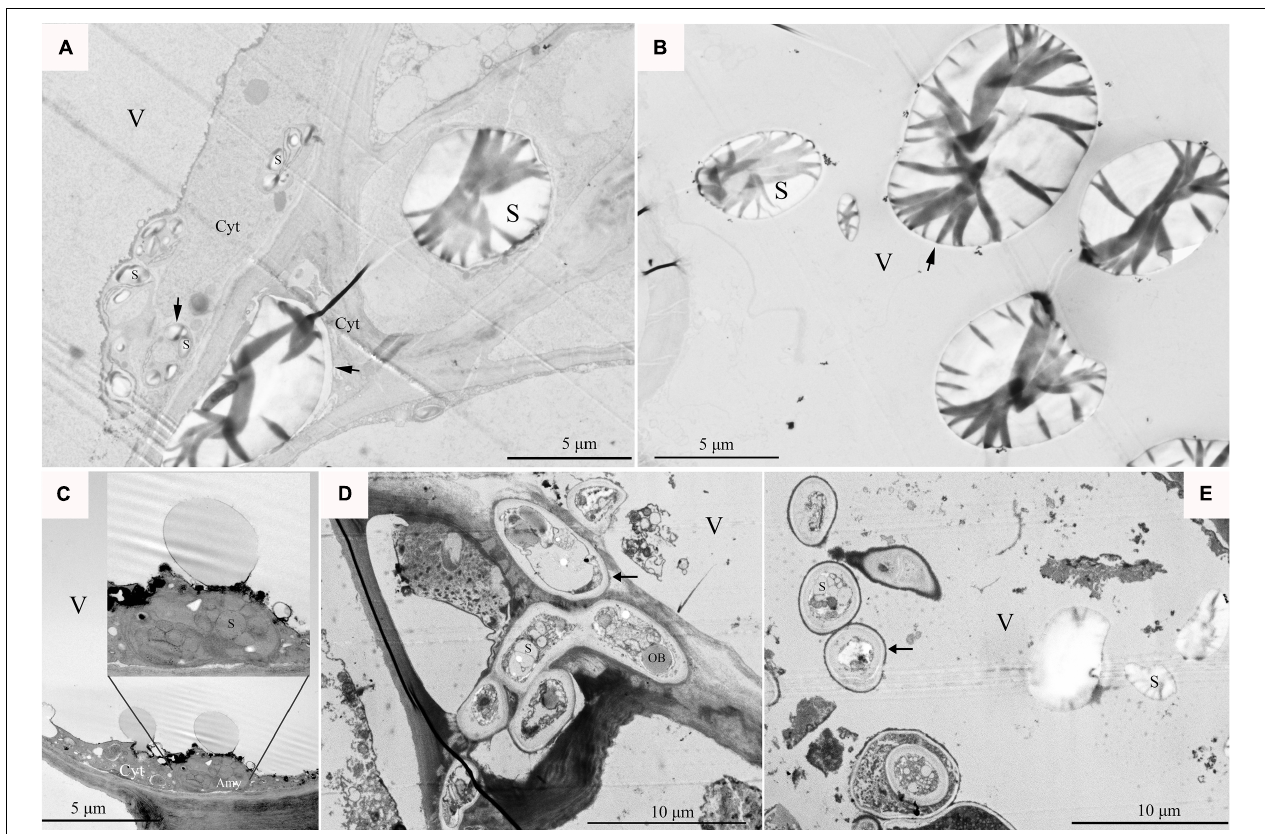
FIGURE 7 | The state of amyloplasts in cells. (A) Flesh cell fragments of an apple with bitter pit, with a large amyloplast located in the cytoplasm. (B) Starch granules were freely lying in the vacuoles in the pulp cells of apples with bitter pit. (C) The amyloplasts contained starch granules and vesicles protruding into vacuoles. The inner image shows an enlarged amyloplast. (D) The amyloplast number increased via division, and the starch contained small starch granules and osmiophilic bodies. The red box shows amyloplast dividing in the protoplast and dissociating in the vacuole. (E) The amyloplasts were freely lying in the vacuoles. V, vacuoles; S, starch granule; OB, osmiophilic body. The arrow indicates the amyloplast similar to